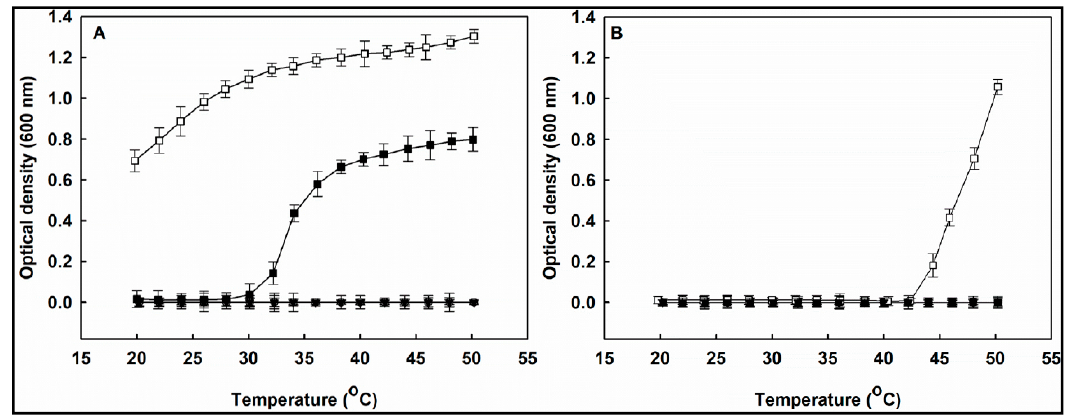
Figure 5. Optical density change of P(HEA- co -PVS)(100/0) ( ● ), P(HEA- co -PVS)(99/1) ( ○ ), P(HEA- co -PVS)(98/2) ( ■ ), P(HEA- co -PVS)(97/3) ( □ ), and P(HEA- co -ABZ) solutions ( ▼ ) with increasing temperature ( A ). Optical density change of H 2 O 2 -P(HEA- co -PVS)(100/0) ( ● ), H 2 O 2 -P(HEA- co -PVS)(99/1) ( ○ ), H 2 O 2 -P(HEA- co -PVS)(98/2) ( ■ ), H 2 O 2 -P(HEA- co -PVS) (97/3) ( □ ), and H 2 O 2 -P(HEA- co -ABZ) solutions ( ▼ ) with increasing temperature ( B ).